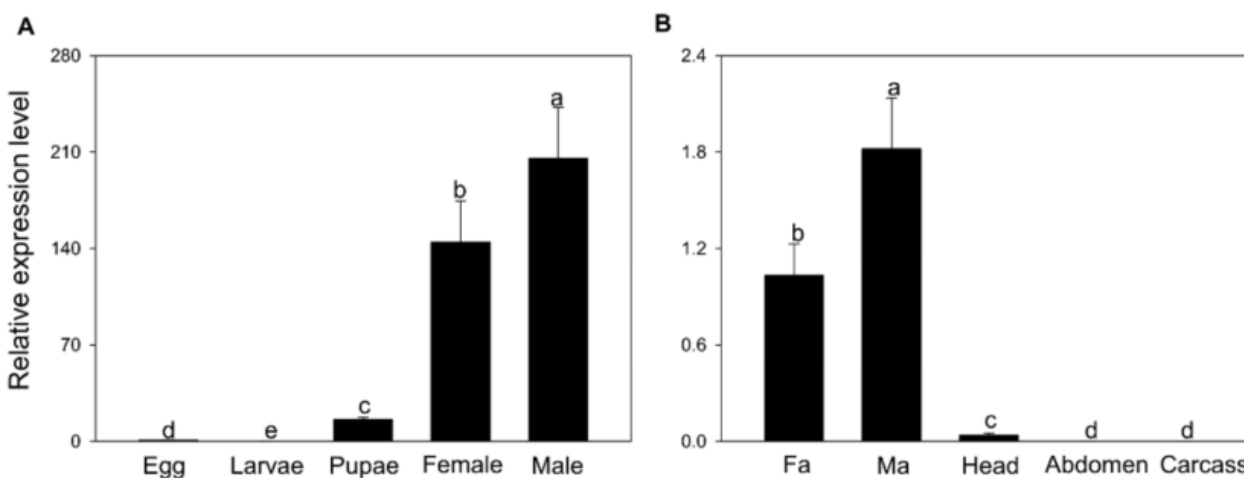
Figure 1. Gene expression profiling of BodoOBP8 in different developmental stages and tissues by RT-qPCR. ( A ) Eggs; larvae; pupae; female; male; ( B ) Fa: female antenna; Ma: male antenna; Head; Carcass: leg + wing + thorax; Abdomen. The expression levels were estimated using the 2 − ∆∆ Ct method. Values are means + SE, and means with different lowercase letters are significantly different ( p < 0.05).